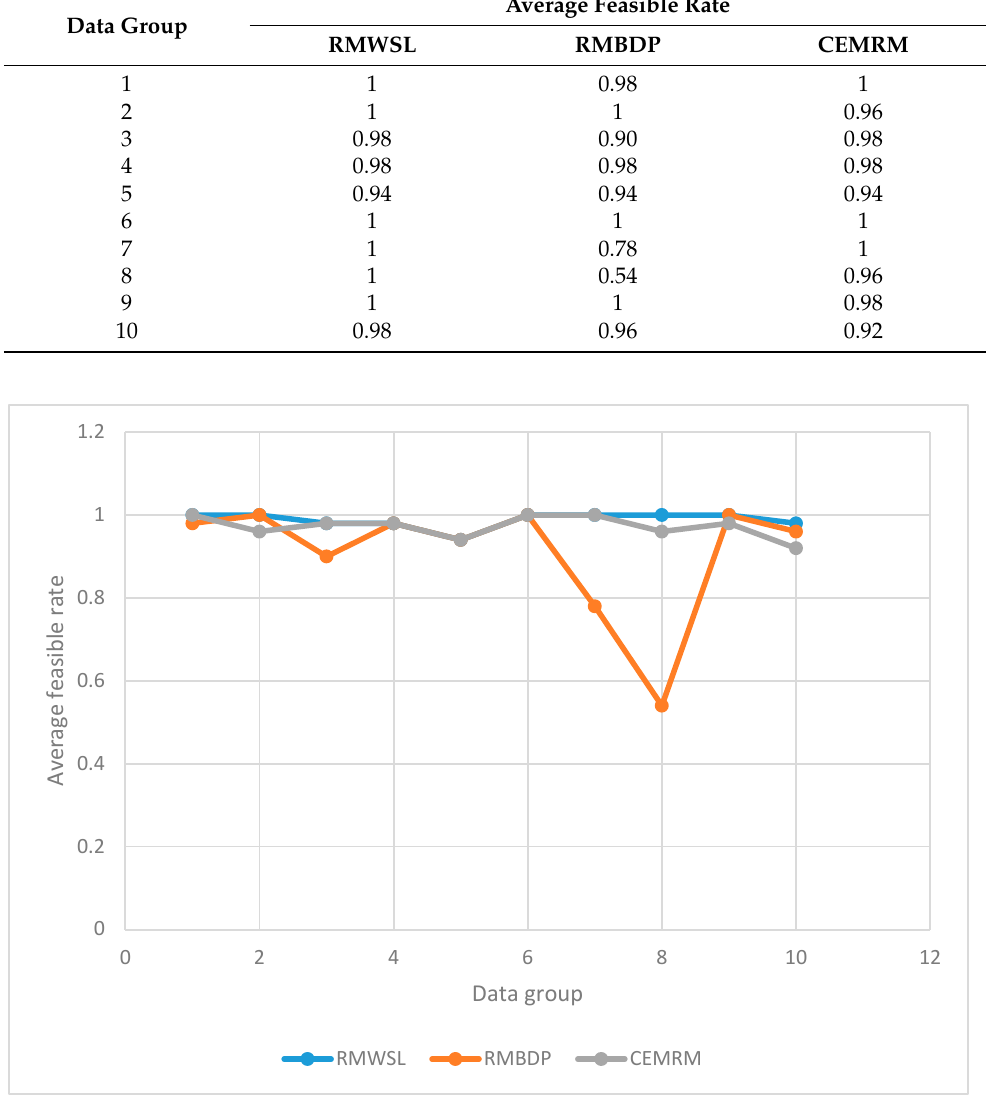
Figure 5. Average feasible rate.